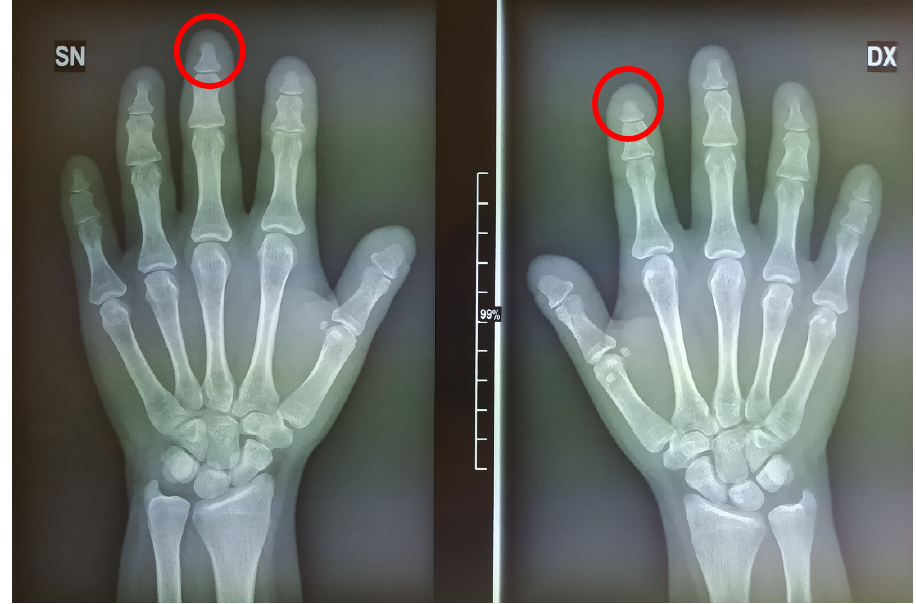
Figure 13. Left- and right-hand X-rays in 2021. Evident short terminal phalanges (red circles marking examples).